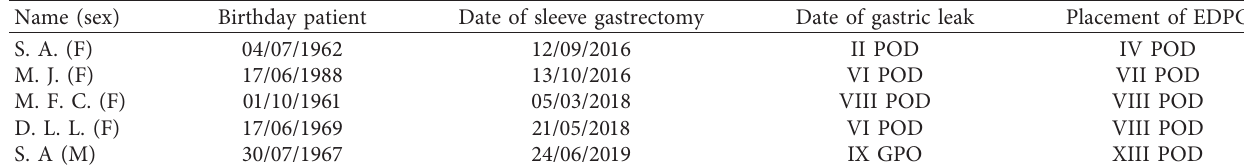
Table 1: Summary of the complicated group (GL group) after LSG.